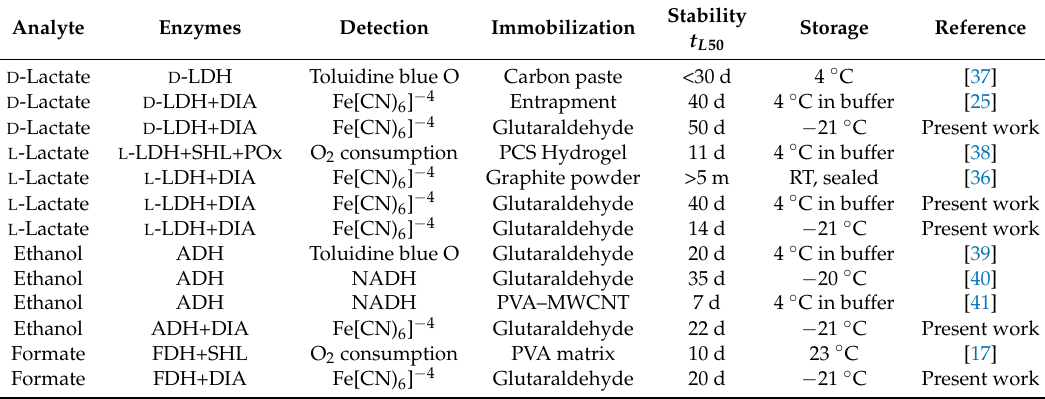
Table 1. Comparison of the storage stability of various enzyme-based biosensors (d: day; m: month; SHL: salicylate hydroxylase; POx: pyruvate oxidase; PCS: poly(carbamoyl)sulfonate; PVA: polyvinyl alcohol; MWCNT: multiwalled carbon